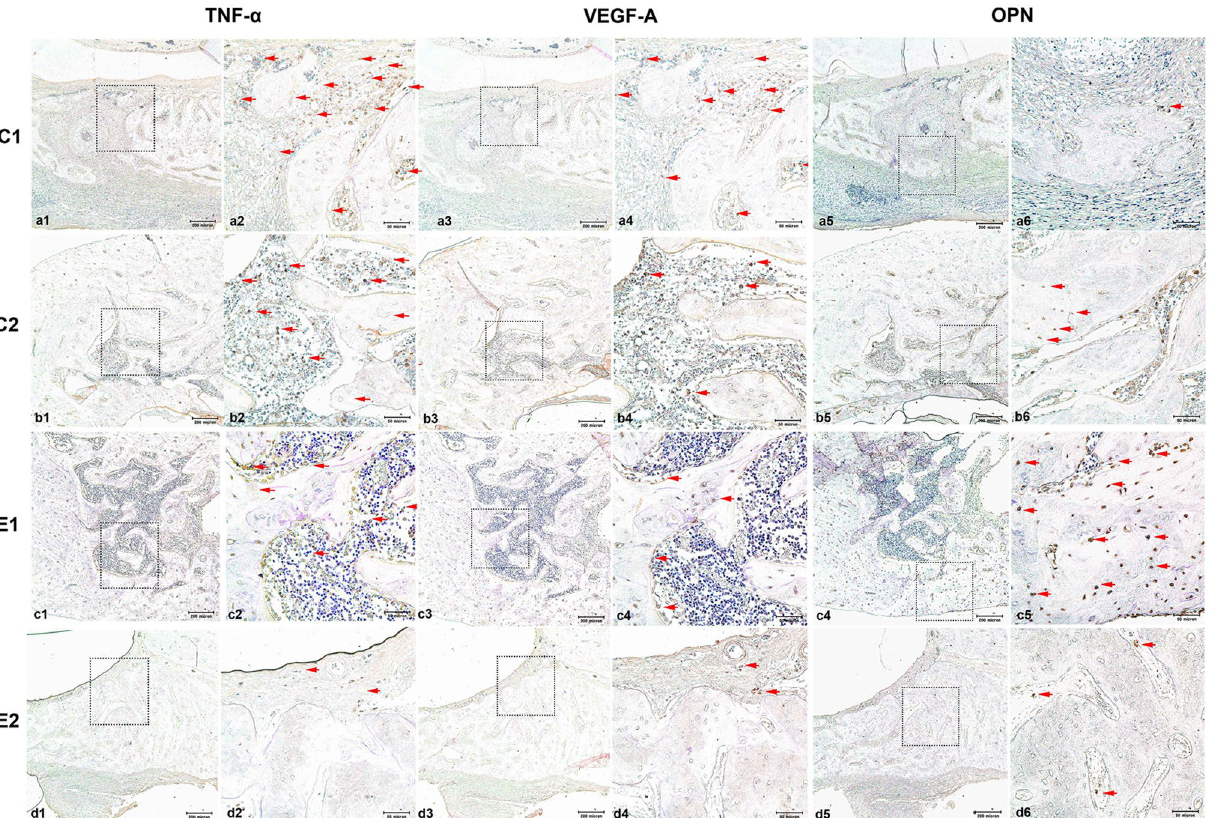
Figure 7. TNF-α, VEGF-A, and OPN antibody staining in the C1 group ( a1 to a6 ), C2 group ( b1 to b6 ), E1 group ( c1 to c6 ), and E2 group ( d1 to d6 ). TNF-α staining with original magnification, 10 × ( a1 ), Magnified image from the selected region from A1, 40 × ( a2 ). VEGF-A staining with original magnification, 10 × ( a3 ), Magnified image from the selected region from a3 , 40 × ( a4 ). OPN staining with original magnification, 10 × ( a5 ), Magnified image from the selected region from a5, 40 × ( a6 ). TNF-α ( b1 to b2 ), VEGF-A ( b3 to b4 ), and OPN ( b5 to b6 ) antibody staining in the C2 group with original magnifications, 10 × , 40 × , respectively. TNF-α ( c1 to c2 ), VEGF-A ( c3 to c4 ), and OPN ( c5 to c6 ) antibody staining in the E1 group with original magnifications, 10 × , 40 × , respectively. TNF-α ( d1 to d2 ), VEGF-A ( d3 to d4 ), and OPN ( d5 to d6 ) antibody staining in the E2 group with original magnifications, 10 × , 40 × , respectively. The red arrowheads mark the stained antibodies in the defect